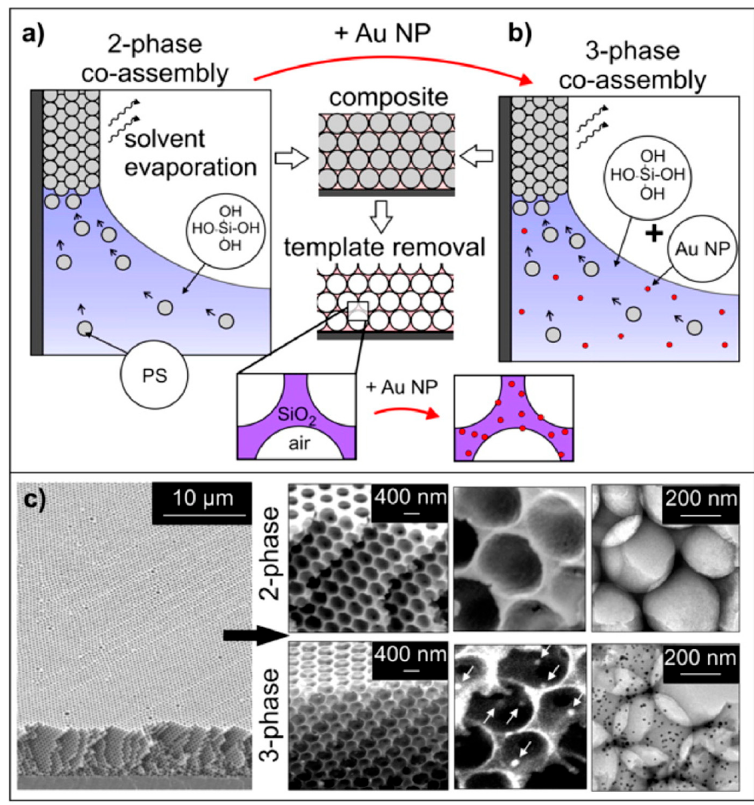
Figure 3. Schematics of: two-phase ( a ); and three-phase ( b ) co-assembly methods. The organic colloidal template was removed via calcination to create an inverse opal structure. In three-phase co-assembly, gold nanoparticles assemble along with the colloids and TEOS that resulted in an inverse opal structure with embedded nanoparticles in the walls; ( c ) SEM and TEM images show the large-scale, ordered, crack-free thin films formed by two- and three-phase co-assembly. SEM and TEM images of Au-loaded inverse opals (bottom) show that three-phase co-assembly leads to films with uniformly distributed nanoparticles in the walls [17].